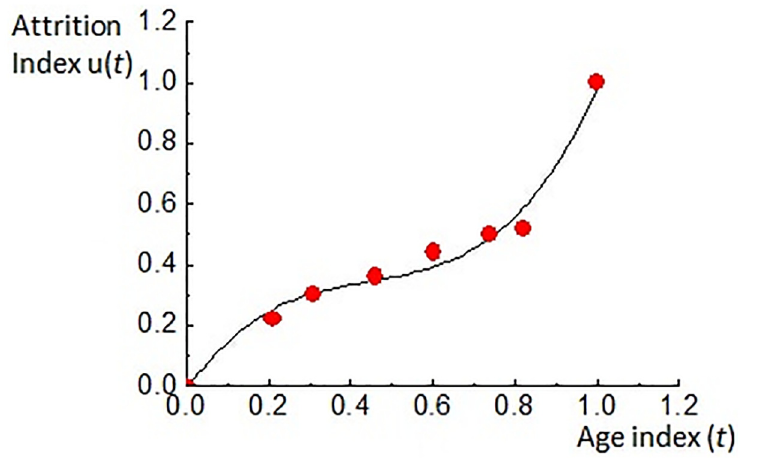
Fig 6. Dynamic distribution curve of